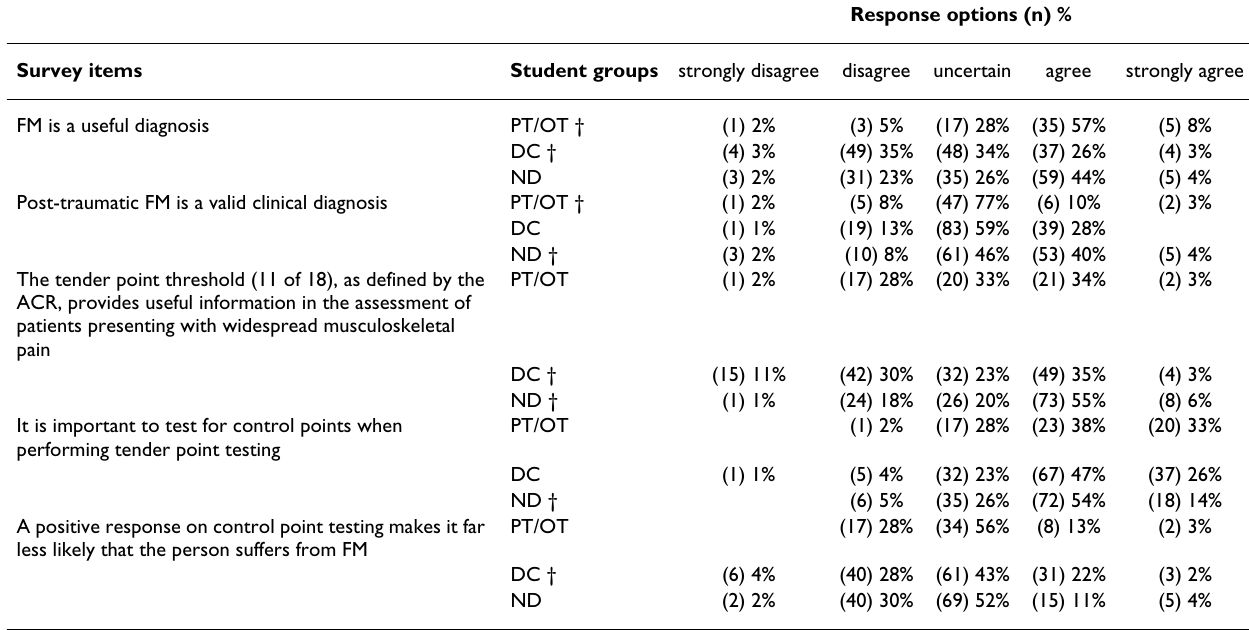
Table 2: Response data to questions on assessment and diagnosis of